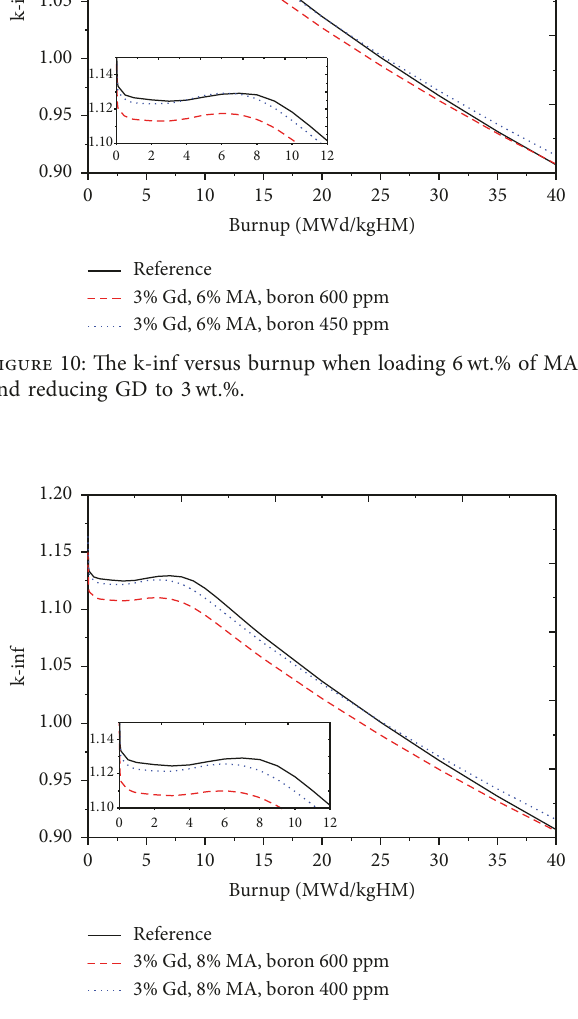
Figure 9: The k-inf versus burnup when loading 10wt.% of MAs and reducing GD to 2.5wt.%.